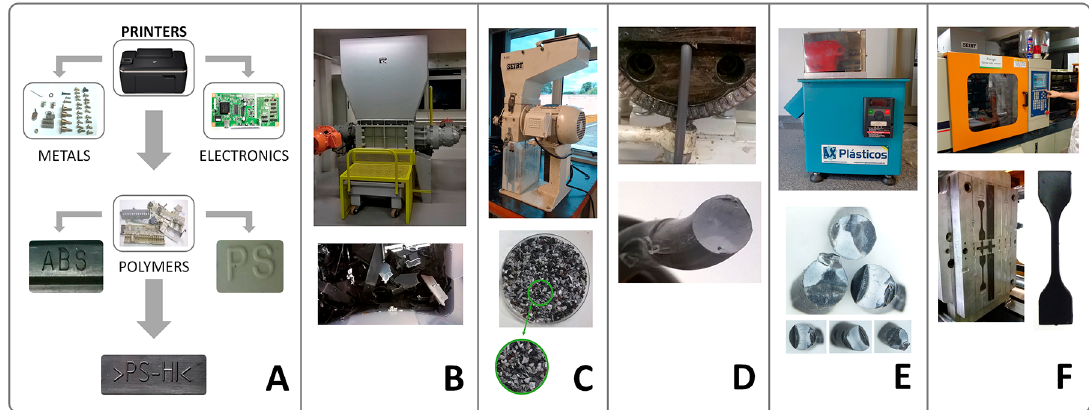
Figure 1. Separation process (A), comminution (B and C), extrusion (D), pelletization (E) and injection (F) of polymers from the